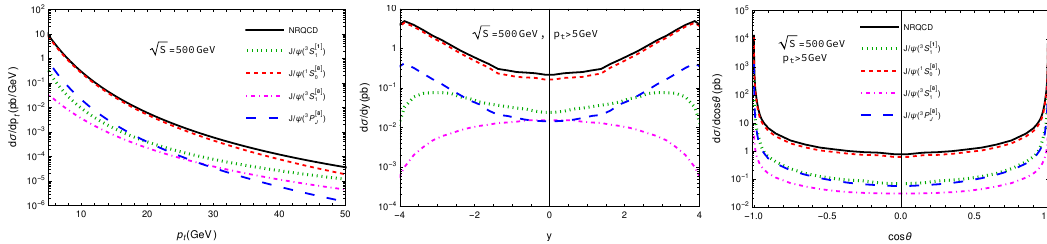
Figure 3 . The p t distributions for prompt J/ψ photoproduction at the ILC (